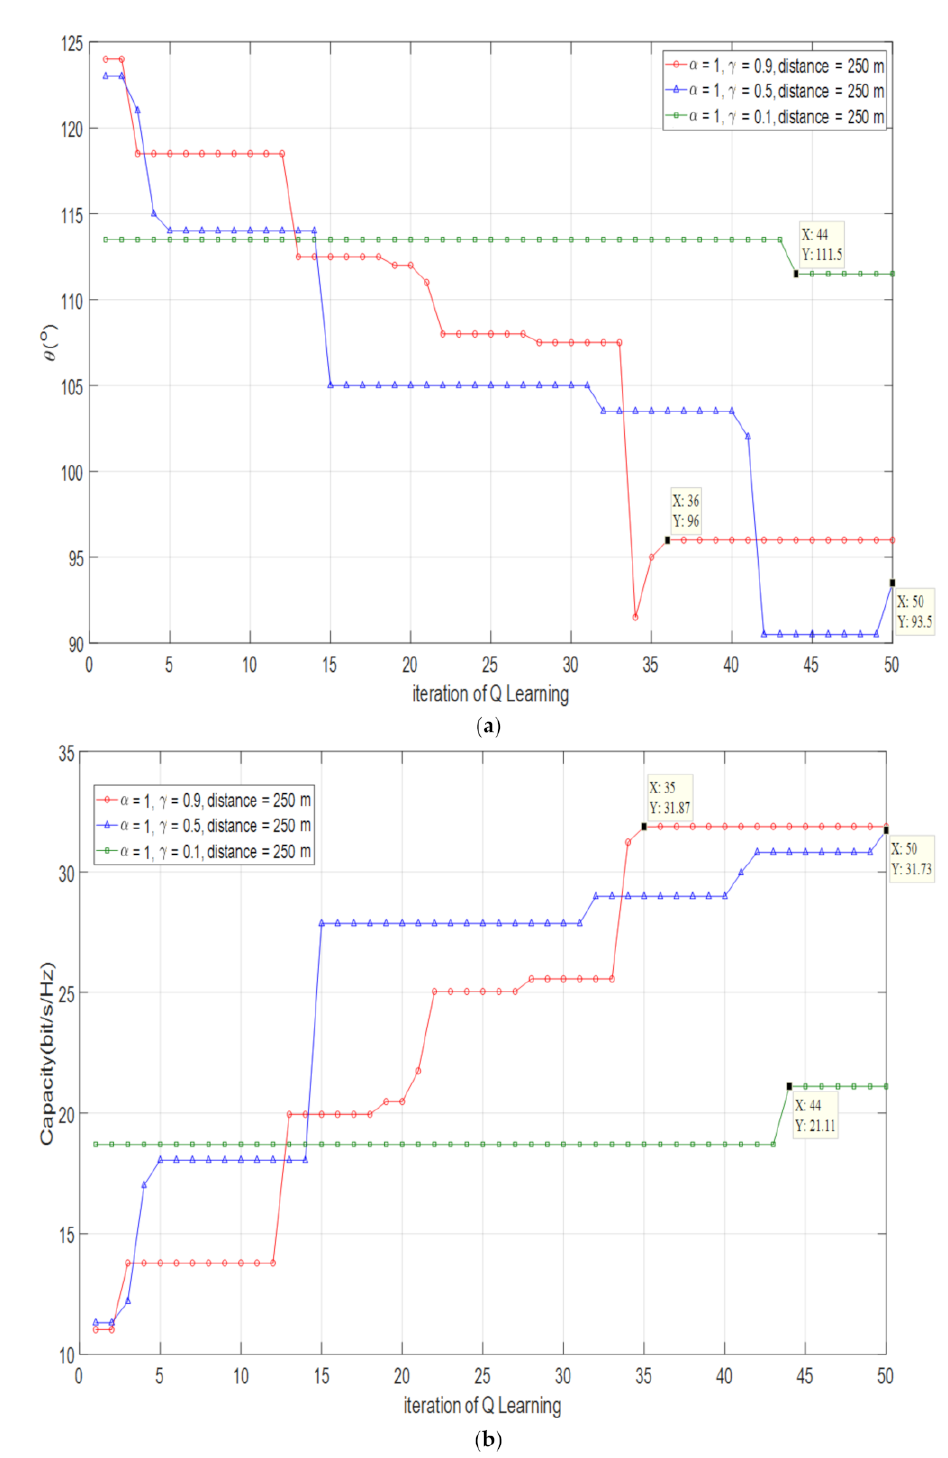
Figure 16. ( a ) Optimized antenna downtilt angle; ( b ) optimized channel capacity. D = 250 m, α = 1 with different γ